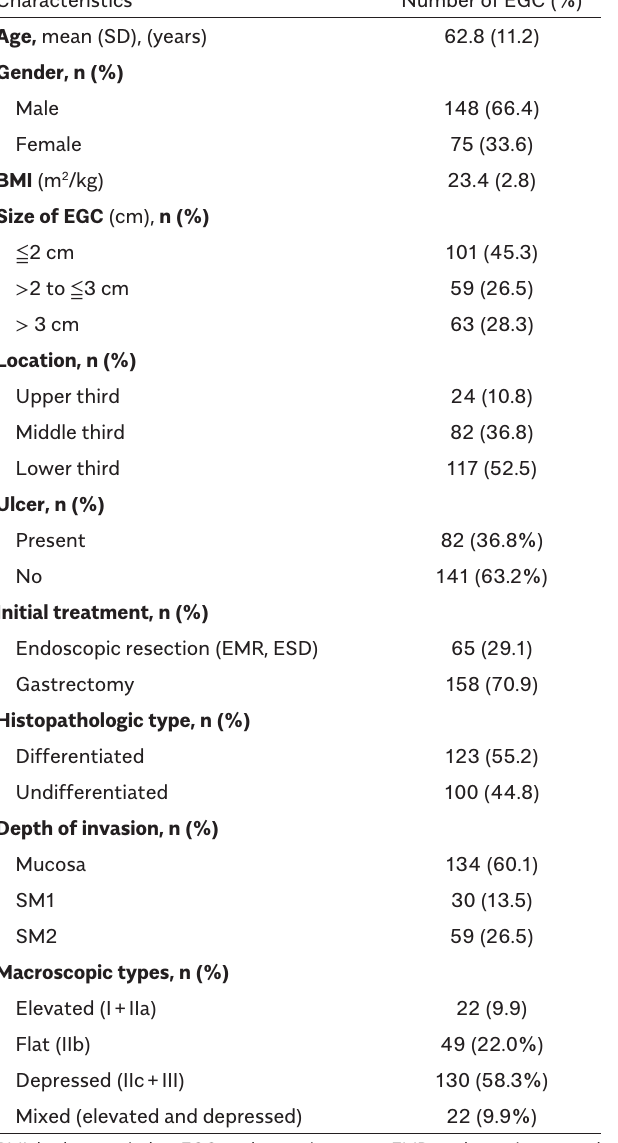
Table 1. Baseline Characteristics of Early Gastric Cancer Patients and Lesions (n = 223) Characteristics